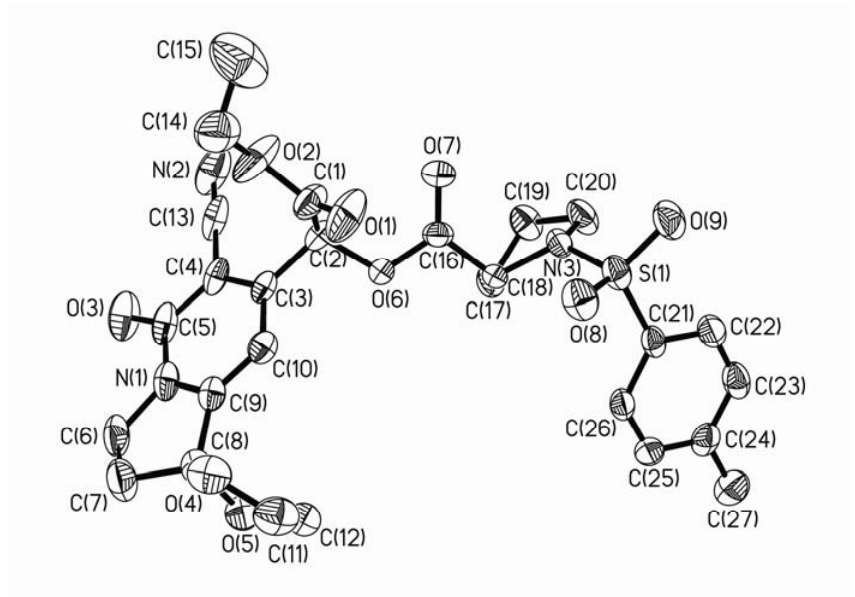
Figure 3. ORTEP drawing and atom labelling scheme of compound 4a.